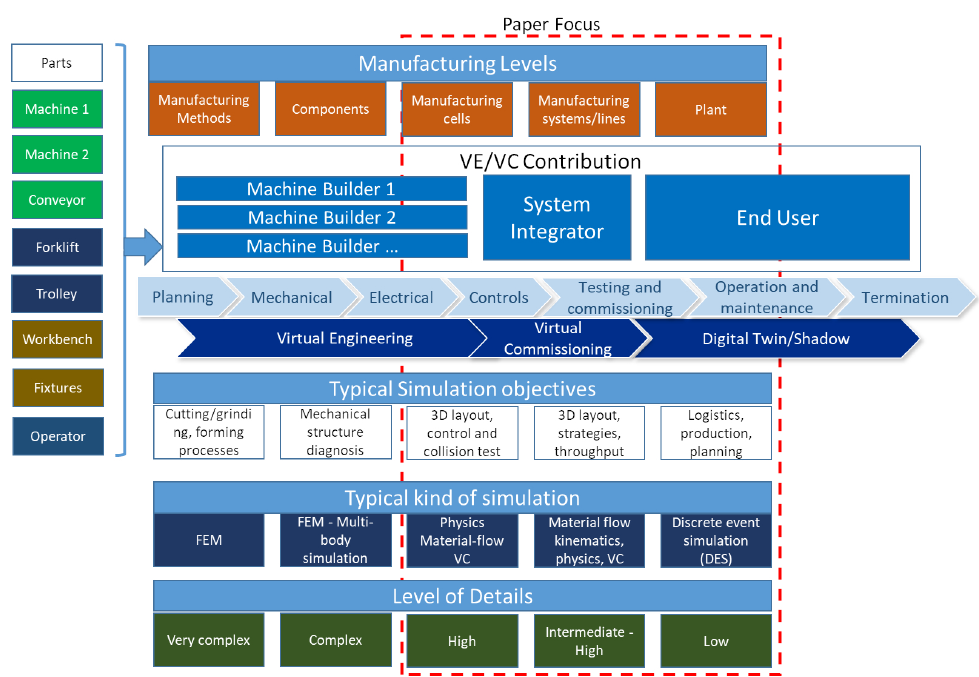
Figure 1. The focus of the current work in the context of manufacturing systems